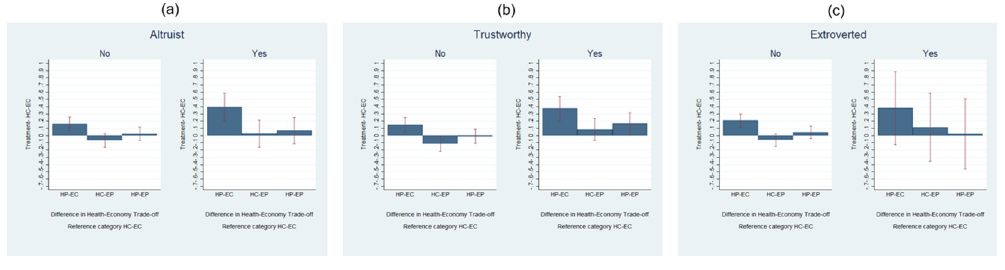
Fig 3. Personality